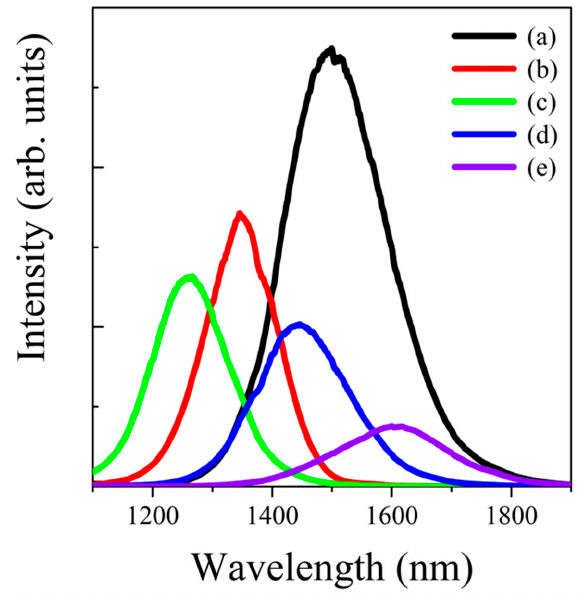
Figure 4. Photoluminescence (PL) spectra of QDs obtained by interdiffusion epitaxy (IDE): irradiated with As for ( a ) 240 s at 470 °C, ( b ) 240 s at 450 °C, ( c ) 240 s at 430 °C, ( d ) 120 s at 470 °C, and ( e ) 480 s at 470 °C.